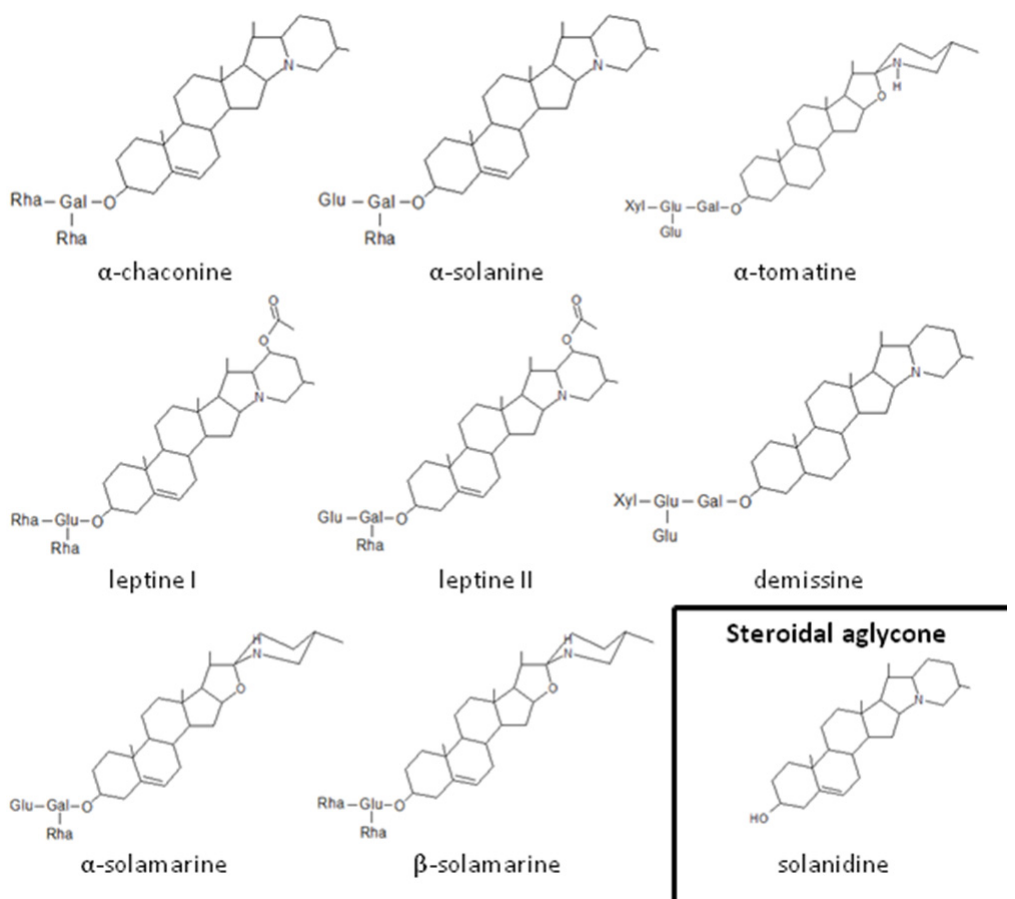
Figure 2. Potential deterrents for Colorado potato beetle, Leptinotarsa decemlineata , include glycoalkaloids and a derived aglycone. Abbreviations for sugar group: Rha: Rhamnose; Gal: Galactose; Glu: Glucose; Xyl: